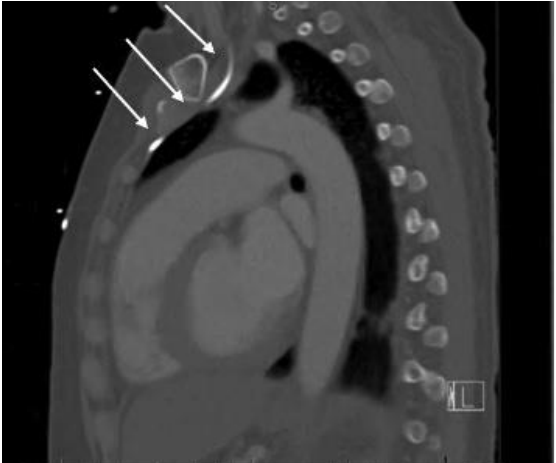
Image 3 . Saggital slice of chest computed tomography demonstrates the central venous catheter within the internal mammary vein, posterior to the sternum, coursing anterior to the great vessels and pleural space (white